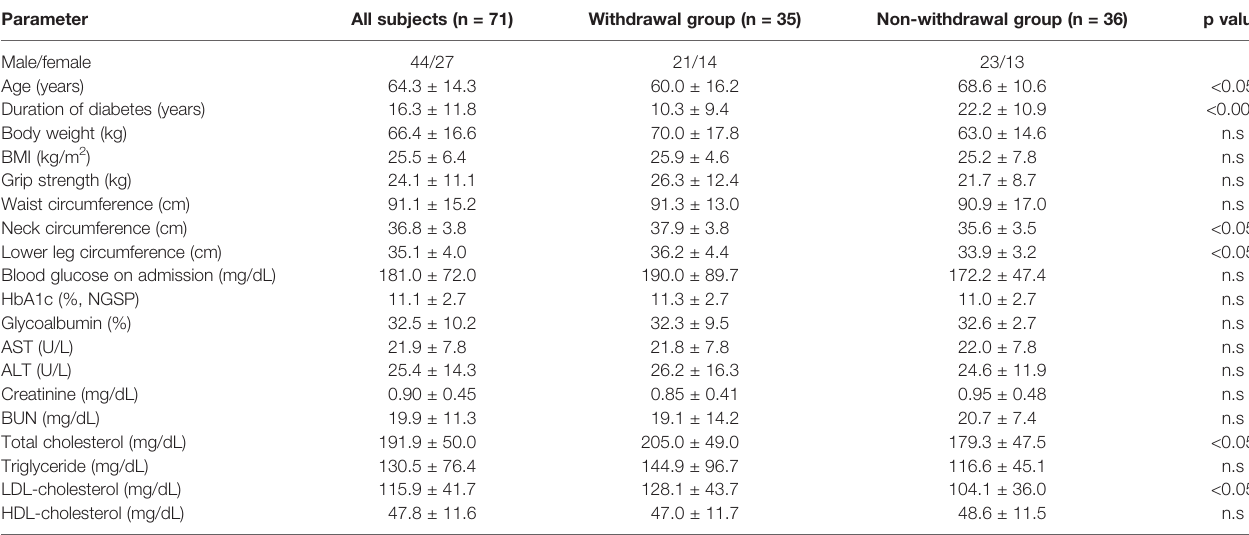
TABLE 1 | Comparison of various values between withdrawal group and non-withdrawal group on admission. Parameter All subjects (n =